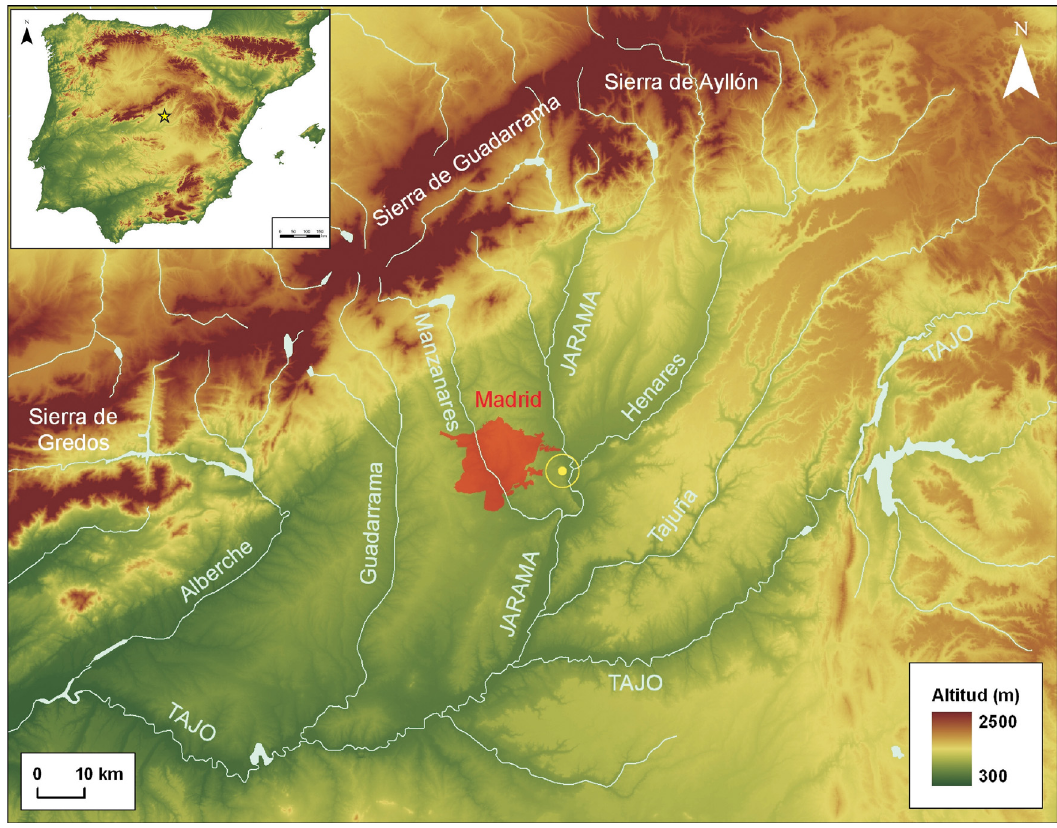
Figure 1: Location of Casa Montero Flint mine. © Casa Montero Project ( Consuegra & Díaz - del - Río, 2015, p. 407, Figure 1 )